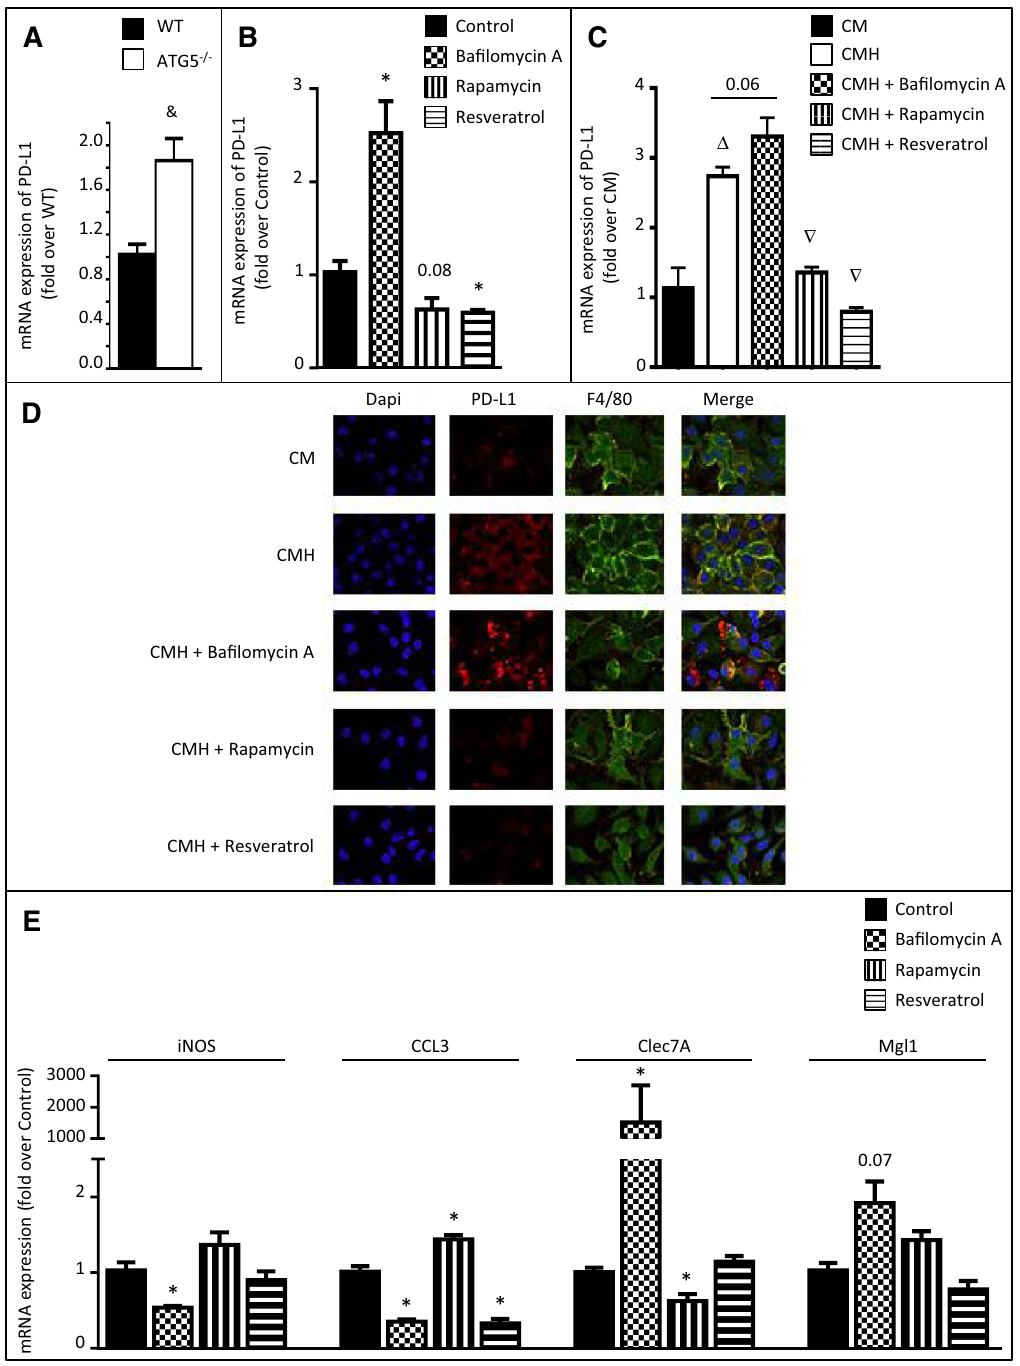
Figure 6. Autophagy regulates PD-L1 expression in macrophages and in TAMs. ( A ) RT-PCR analysis of PD-L1 mRNA in peritoneal macrophages isolated from WT or ATG5 Mye−/− mice. ( B ) RT-PCR analysis of PD-L1 mRNA in RAW264.7 cells in the presence or absence of 100 nM bafilomycin A, 100 nM rapamycin or 30 µM resveratrol. ( C ) RT-PCR analysis of PD-L1 mRNA in peritoneal macrophages exposed to the conditioned medium of Hepa1-6 cells (CMH) or to control medium (CM) in the presence or absence of 100 nM bafilomycin A, 100 nM rapamycin or 30 µM resveratrol. ( D ) Representative images of PD-L1 (red), F4/80 (green) and Dapi (blue) labeling in peritoneal macrophages exposed to control medium (CM) or to the conditioned medium of Hepa1-6 cells (CMH) in the presence or absence of 100 nM bafilomycin A, 100 nM rapamycin or 30 µM resveratrol (original magnification × 400). ( E ) RT-PCR analysis of iNOS, CCL3, Clec7A and Mgl1 mRNA in peritoneal macrophages in the presence or absence of 100 nM bafilomycin A, 100 nM rapamycin or 30 µM resveratrol. Data are shown as mean ± SEM of 6 samples per condition. & p < 0.05 for WT vs ATG5 −/− , *p < 0.05 for treatment vs control, Δ p < 0.05 for CMH vs CM, ∇ p < 0.05 for CMH vs CMH + bafilomycin A or CMH + rapamycin or CMH +